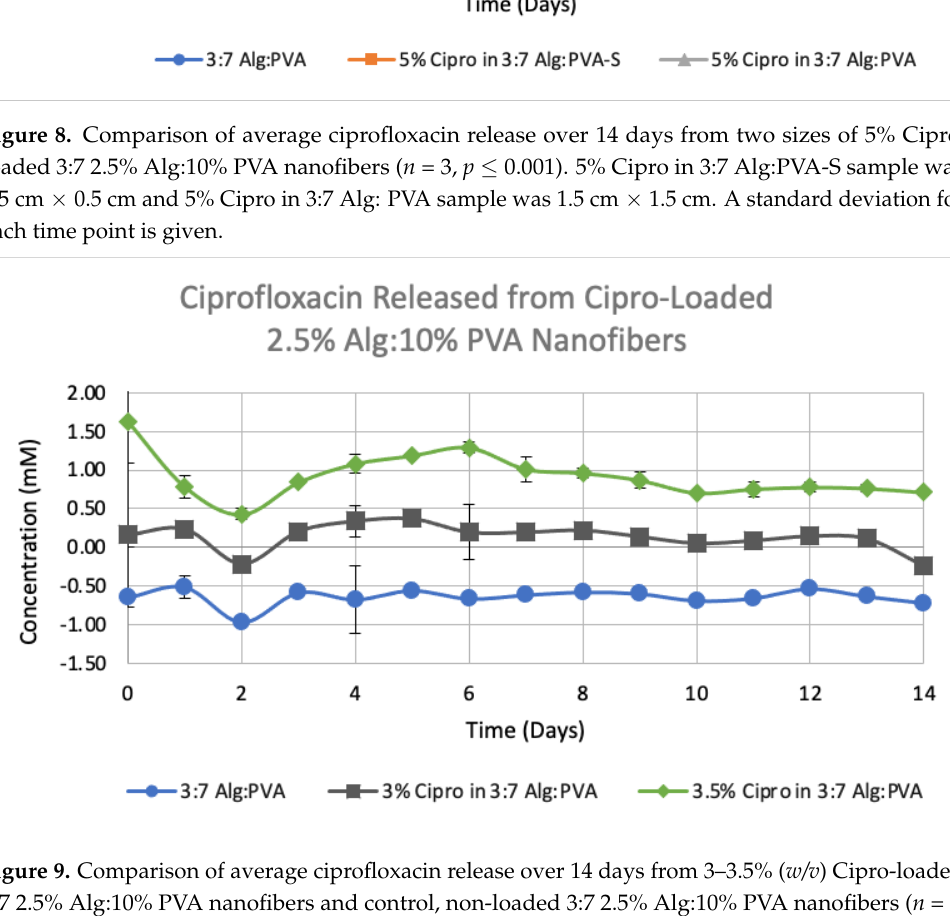
Table 1. Compilation of Alg-PVA Release Study Runs.